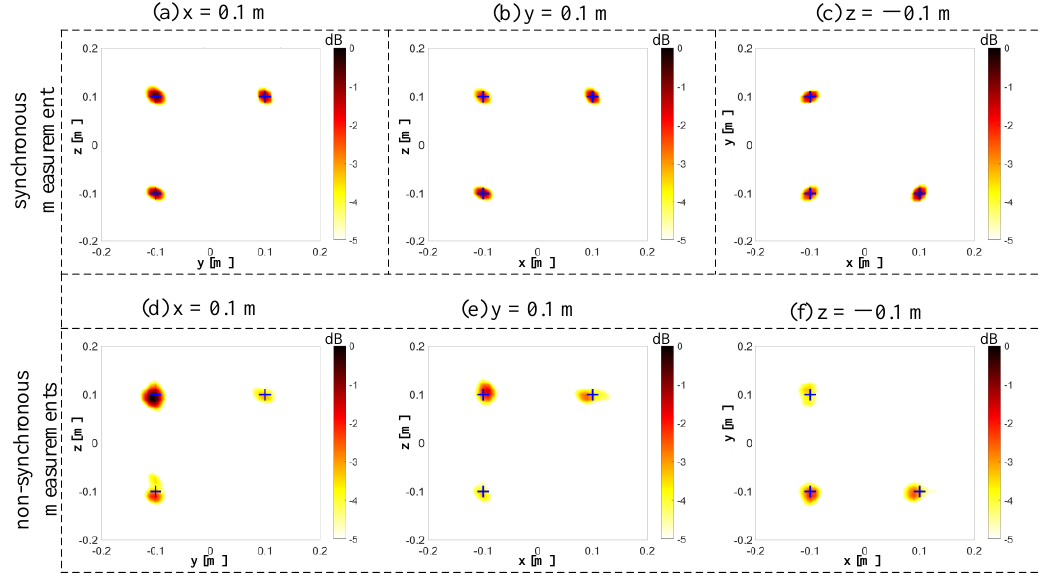
Figure 13. The beamforming results of the synchronous and non-synchronous measurements at 6000 Hz. ( a ) The beamforming map of the synchronous measurement at the x = 0.1 m slice. ( b ) The beamforming map of the synchronous measurement at the y = 0.1 m slice. ( c ) The beamforming map of the synchronous measurement at the z = − 0.1 m slice. ( d ) The beamforming map of the non-synchronous measurements at the x = 0.1 m slice. ( e ) The beamforming map of the non-synchronous measurements at the y = 0.1 m slice. ( f ) The beamforming map of the non-synchronous measurements at the z = − 0.1 m slice.